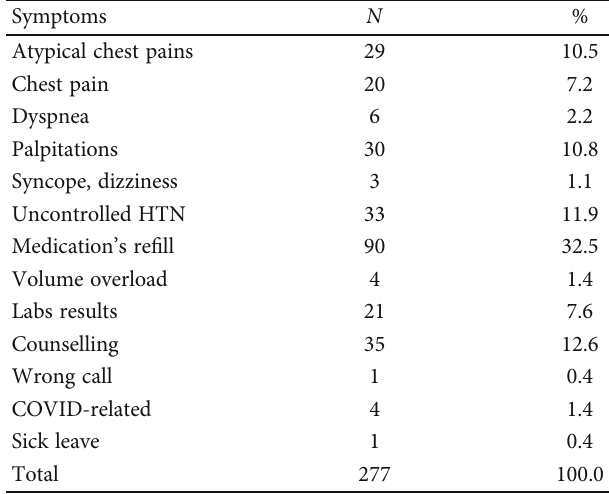
Table 1: Cardiac symptoms among callers to Virtual Cardiology clinic.